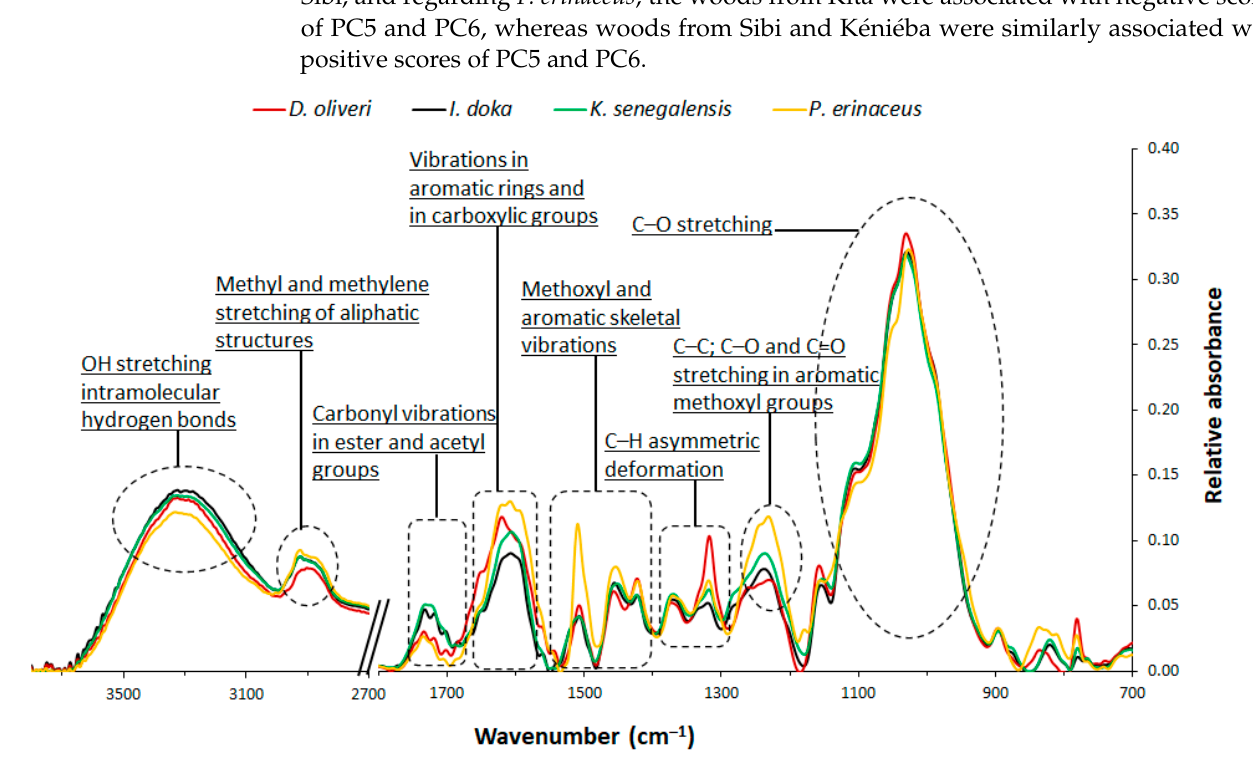
Figure 4. Average FTIR absorption spectra of the studied wood species, indicating the related bond vibrations for FTIR absorption bands. Table 4. Summary of the one-way ANOVA using component scores of PCA